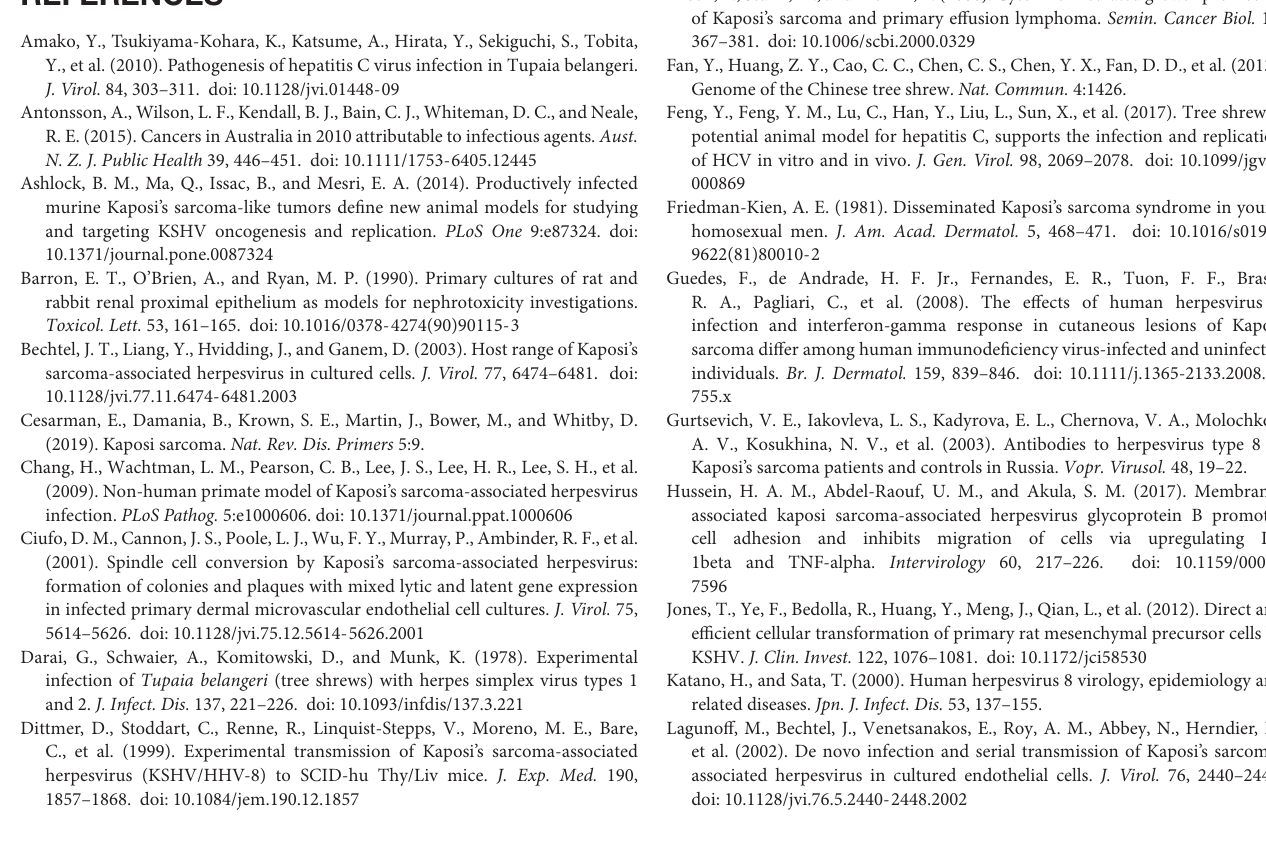
magnification, 20 × .